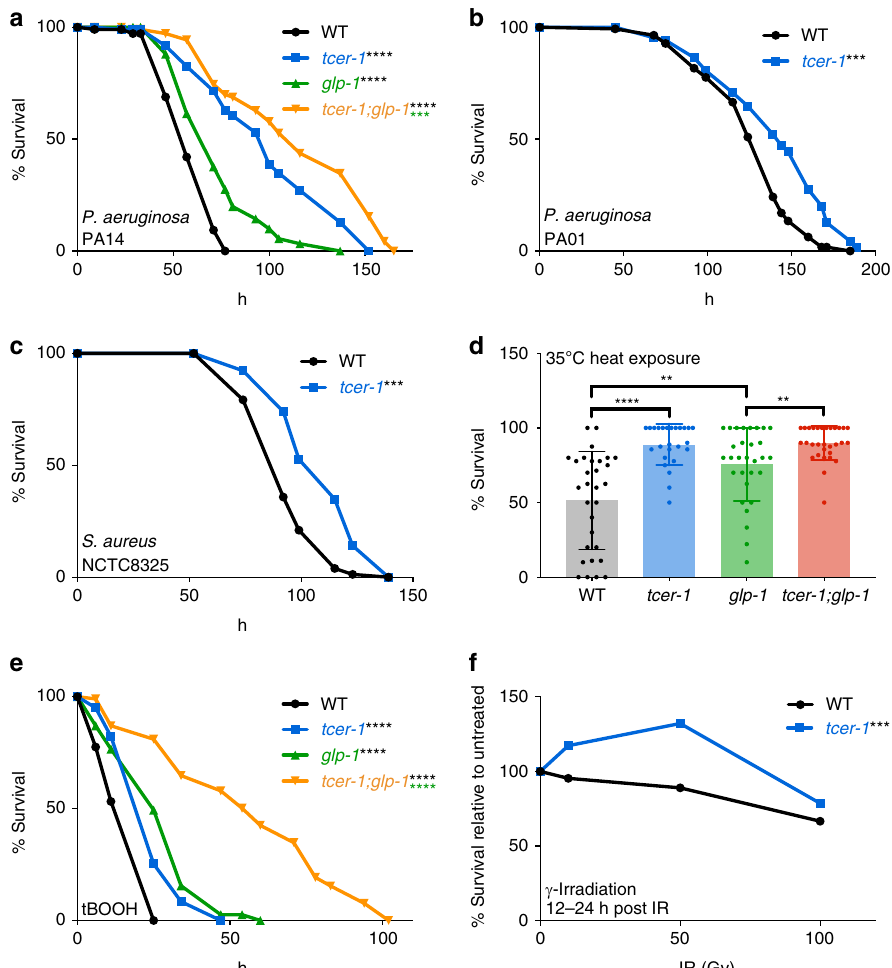
Fig. 1 Loss of TCER-1 enhances resistance against multiple biotic and abiotic stressors. Survival of L4 stage, wild-type C. elegans (WT, black), tcer-1 (blue), glp-1 (green) and tcer-1;glp-1 (orange) mutants exposed to different stressors. a – c Pathogen exposure. a P. aeruginosa PA14: WT ( m = 59.35 ± 1.3, n = 89/ 106), tcer-1 ( m = 98.6 ± 3.5, n = 83/109, P vs. WT <0.001), glp-1 ( m = 72.86 ± 2.1, n = 102/109, P vs. WT <0.0001) and tcer-1;glp-1 ( m = 114.18 ± 3.9, n = 81/106, P vs. glp-1 <0.001). b P. aeruginosa PA01: WT ( m = 126.43 ± 2.4, n = 118/142), tcer-1 ( m = 139.98 ± 2.7, n = 143/173, P vs. WT <0.001). c S. aureus : WT ( m = 94.67 ± 1.5, n = 97/111), tcer-1 ( m = 109.27 ± 1.5, n = 145/169, P vs. WT <0.001). d Heat stress: survival of day 2 adults 12 h after exposure to 35 °C for 6 h. n = 50 − 100 animals per strain per each of six biological replicates analyzed using unpaired two-tailed t test. e Oxidative stress: survival of